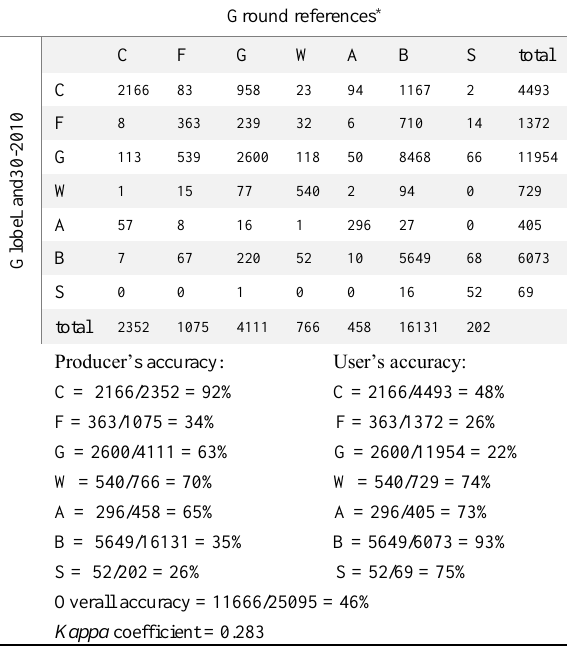
Table 2. Error matrix and accuracy measures